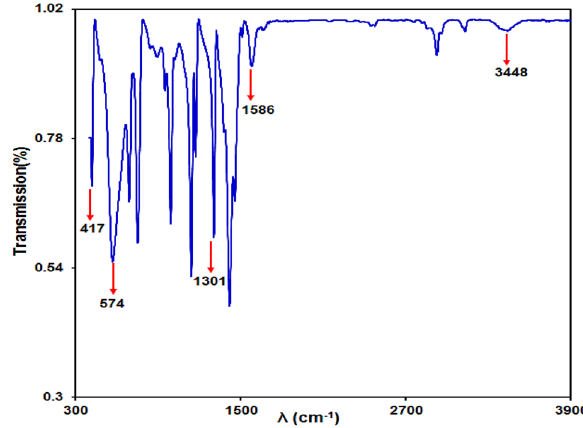
Figure 2. The Fe 3 O 4 @ZIF-8 NPs FT-IR spectrum.